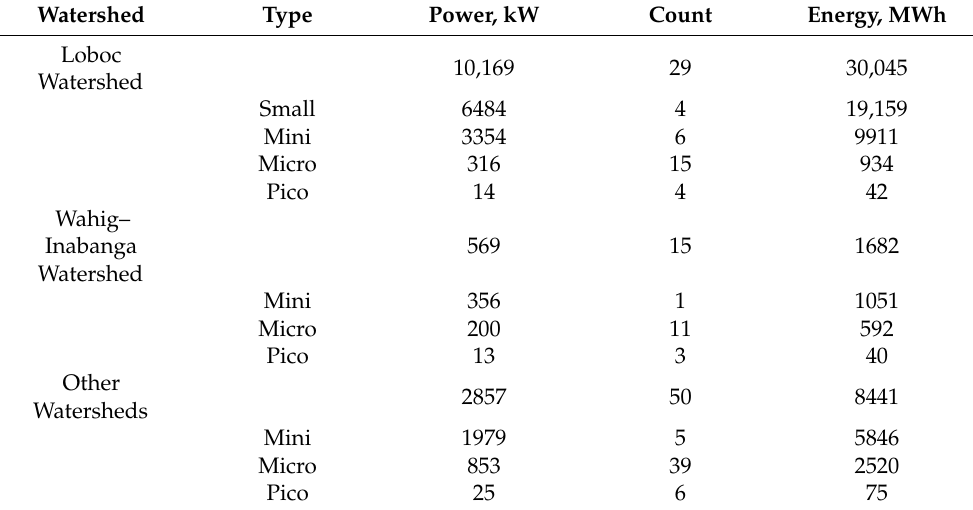
Table 5. Types of small-scale hydropower sites, count, power capacity, and energy generation per